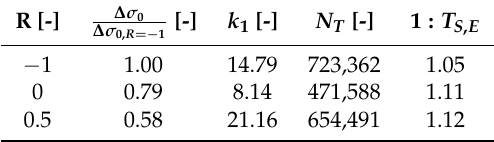
Table 2. Results of the high-cycle fatigue tests.